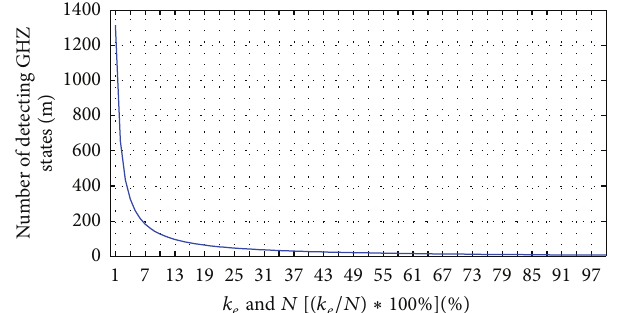
Figure 10: The legitimate users detect eavesdropper with 100% probability corresponding to the number of detecting GHZ states and percentage of replaced GHZ